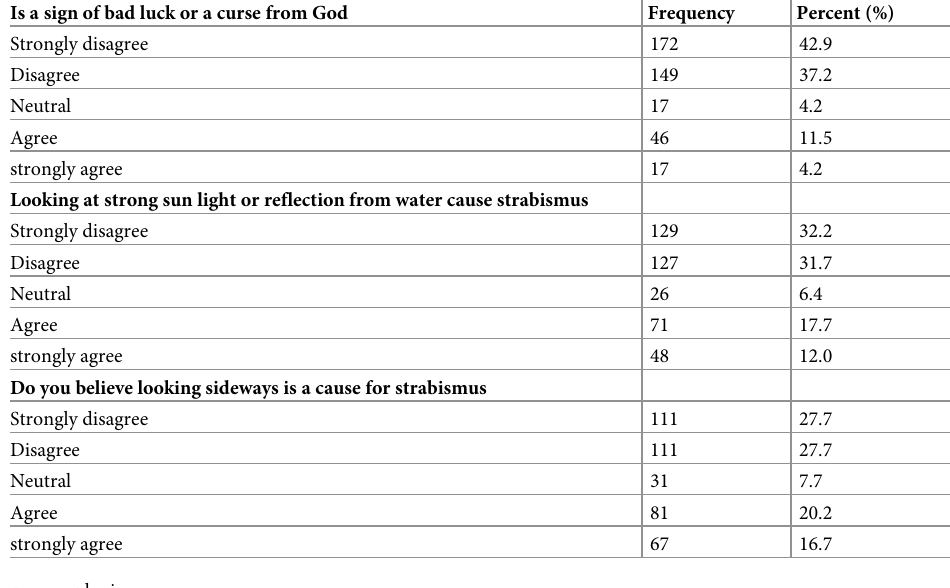
Table 4. Attitude of respondents towards causes of strabismus concerning the cause of strabismus in Woreta town, Northwest Ethiopia, 2020 (n = 403). Is a sign of bad luck or a curse from God Frequency Percent (%) Strongly disagree 172 42.9 Disagree Neutral Agree strongly agree Looking at strong sun light or reflection from water cause strabismus Strongly disagree Disagree Neutral Agree strongly agree Do you believe looking sideways is a cause for strabismus Strongly disagree Disagree Neutral Agree strongly